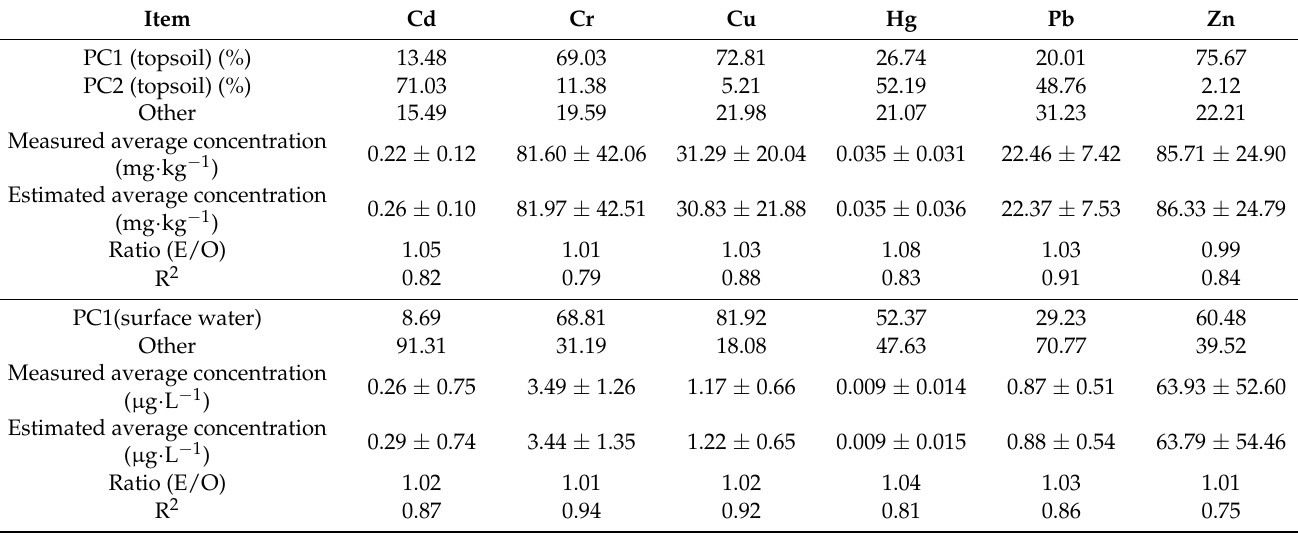
Table 12. Common factor contribution rate of heavy